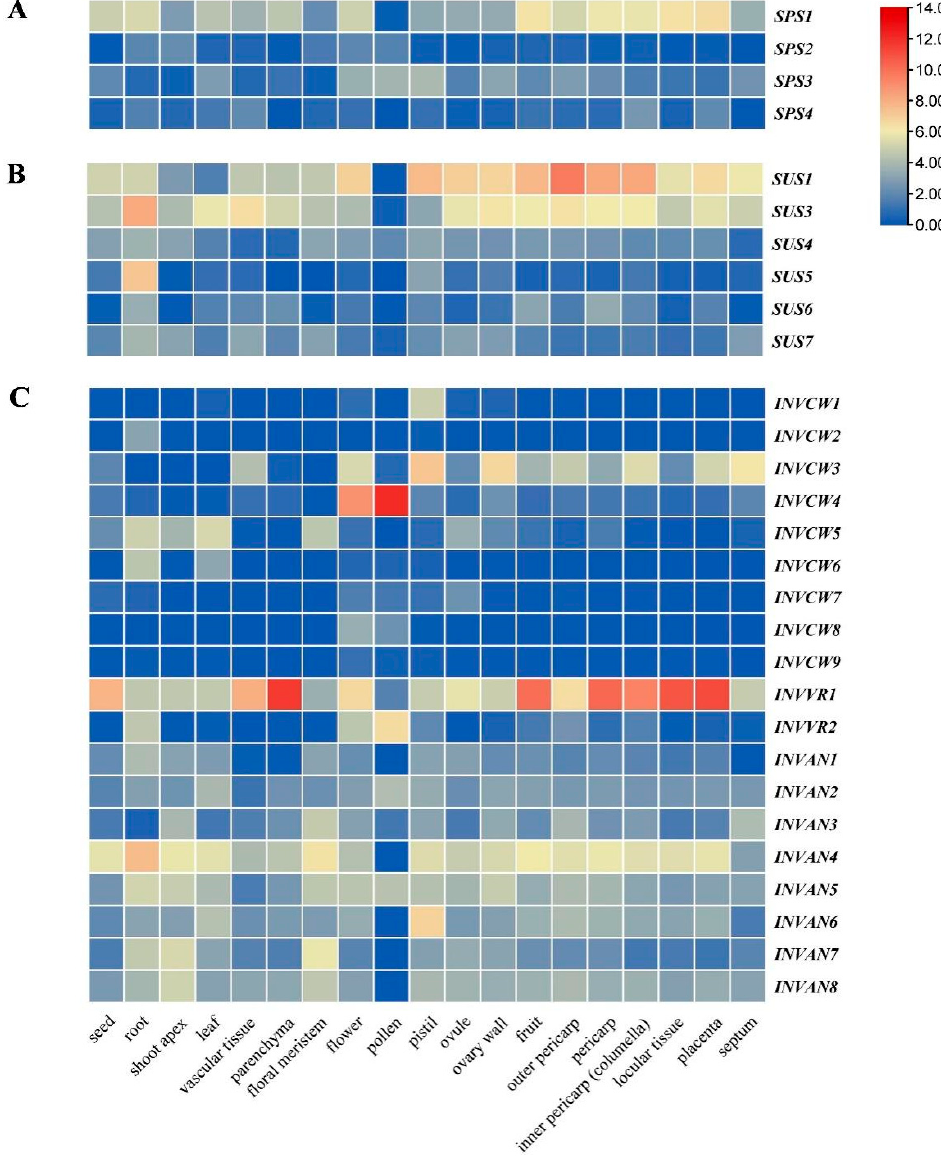
Figure 6. Tissue expression pattern of SPS , SUS and INV genes in tomato. The expression values were retrieved from large scale RNA-seq with Genevestigator. ( A ) SPS expression; ( B ) SUS expression; ( C ) INV expression.